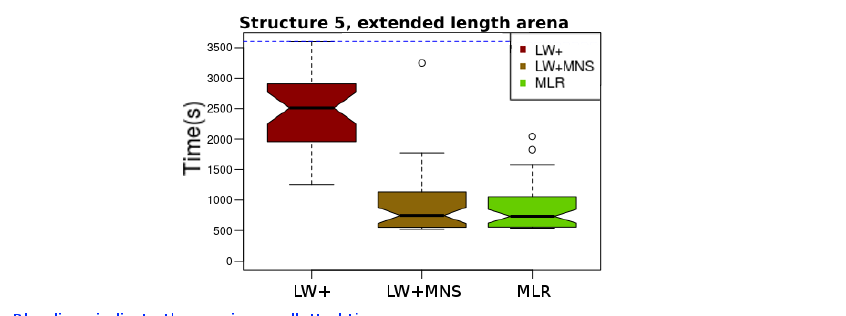
Figure 9. Structure 5 had good performance in the 3 m and 5 m wide 10 m long arenas for both of the dynamic self-assembly strategies, with their superiority over the LW+ strategy being more pronounced than for the Structure 1 scenarios. The extension of the corridor length to 20 m in this scenario clearly gives more benefit to the strategies that can assemble as they move, with A-test measures rising to 0.96 and 0.98 for the LW + MNS and MLR strategies, respectively, over LW+. An aspect to this success may be that, as the space increases in length, the density of wandering robots decreases and therefore it becomes more difficult for a robot staying stationary with the LW+ strategy to have anything better than a very slow rate of recruits wandering close enough to